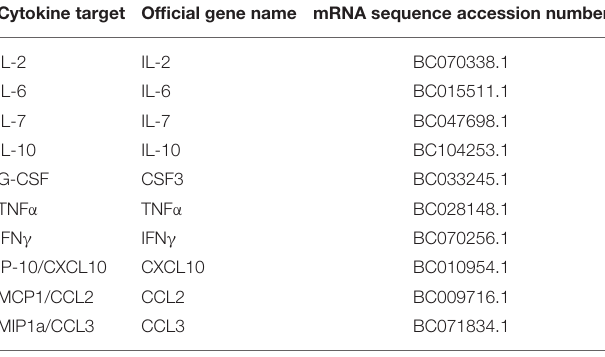
TABLE 3 | The most significant lncRNAs associated with COVID-19 cytokine storm cytokines, along with the lncRNA accession